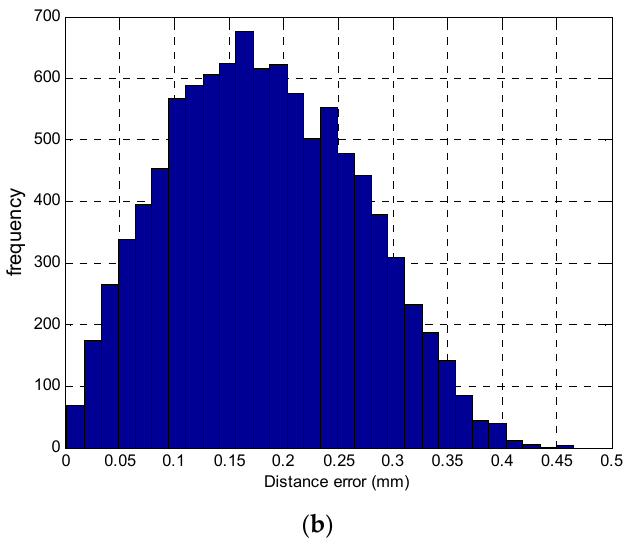
Figure 16. ( a ) Simulation of the error in the point of incidence calculation; ( b ) Distribution of euclidean distance error for the central point.